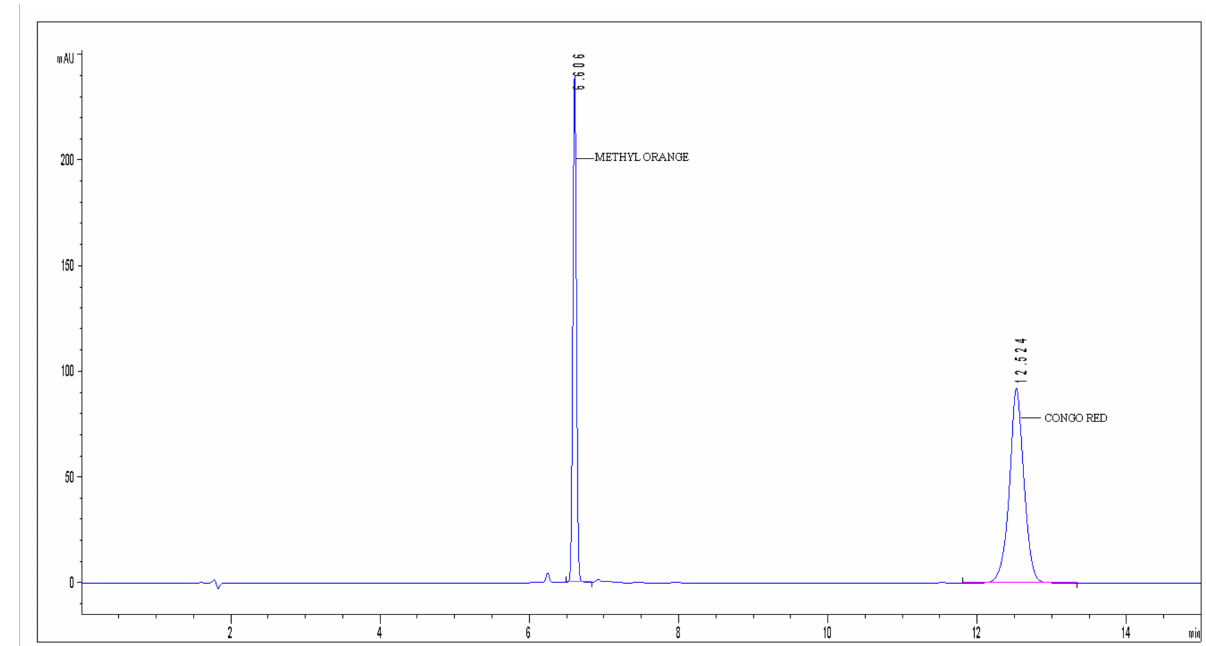
Figure 1. The chromatogram obtained from the analysis of a mixed solution of MO and